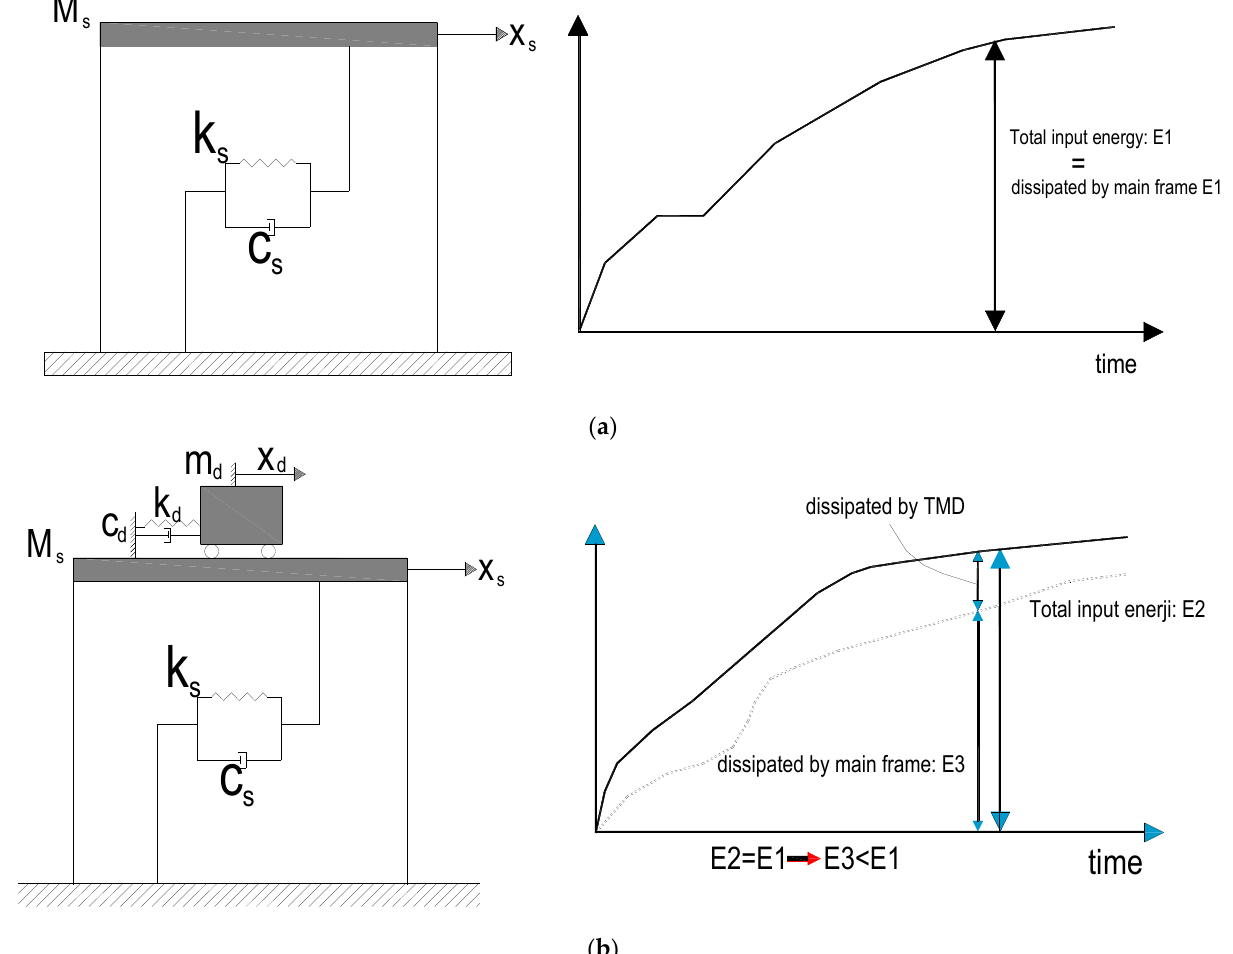
Figure 1. Total input energy applied to: ( a ) an SDF system without TMD and ( b ) an SDF system with TMD.